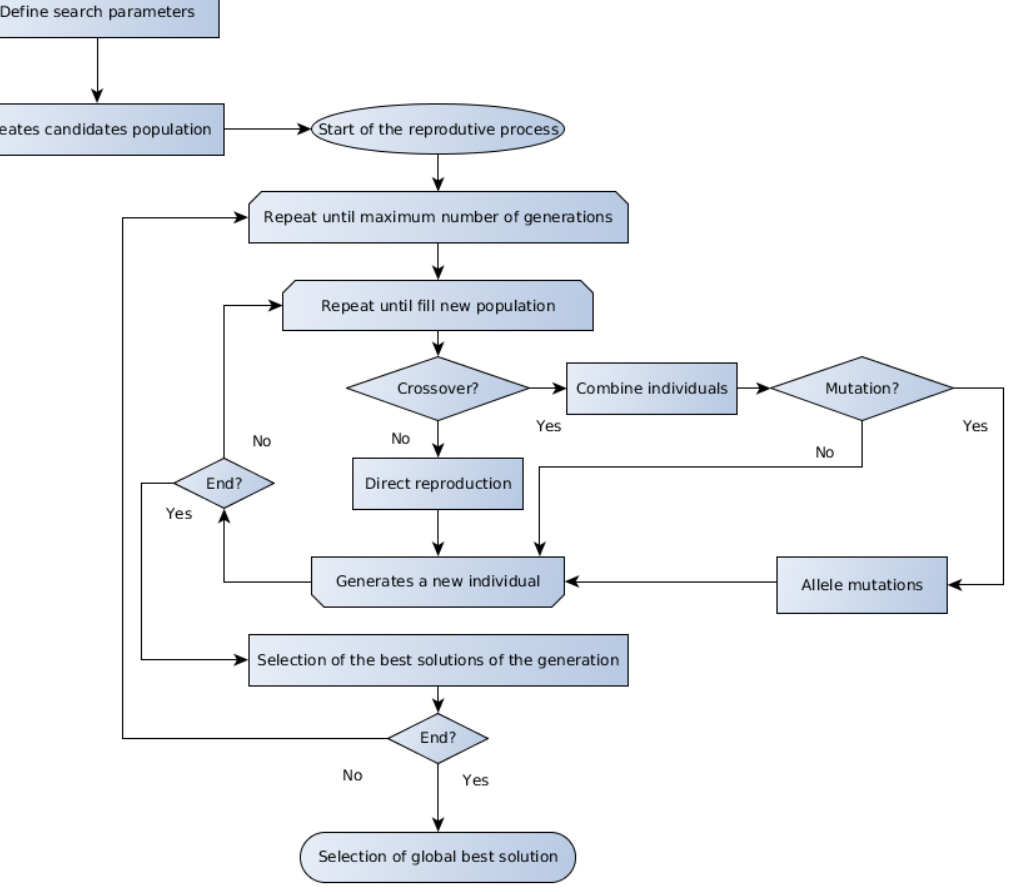
Figure 1. Schematic representation of the GA